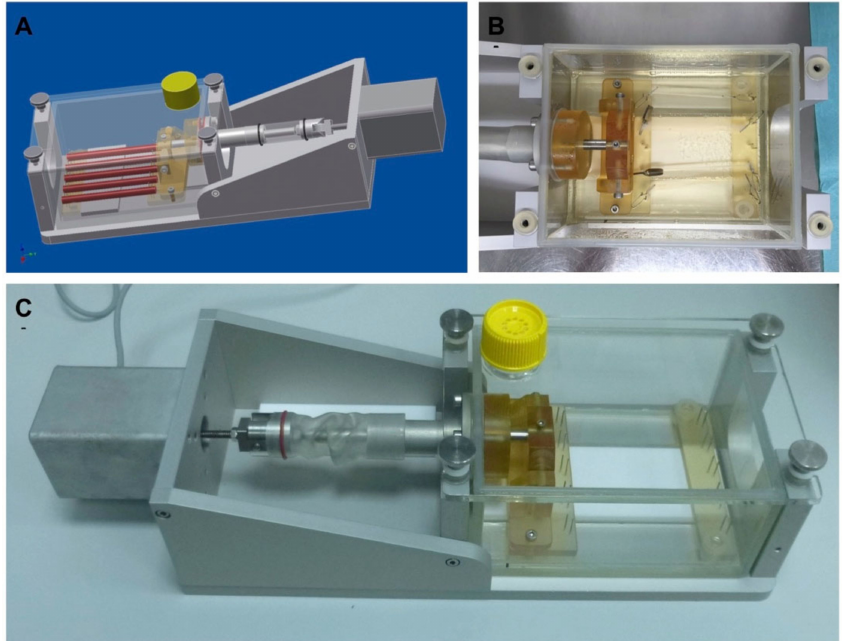
Figure 2. Custom-made bioreactor for uniaxial cyclic strain of tendon like constructs. ( A ): Design drawing of the bioreactor. ( B ): Top view of the bioreactor filled with constructs and cell medium. ( C ): General view of the bioreactor with drive motor, but without control